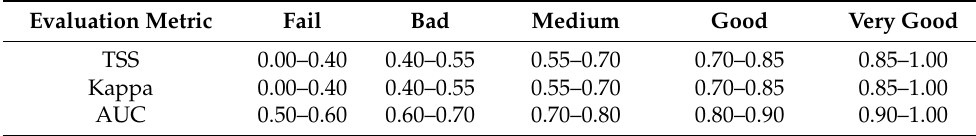
Table 3. Measurement standard for TSS, Kappa and